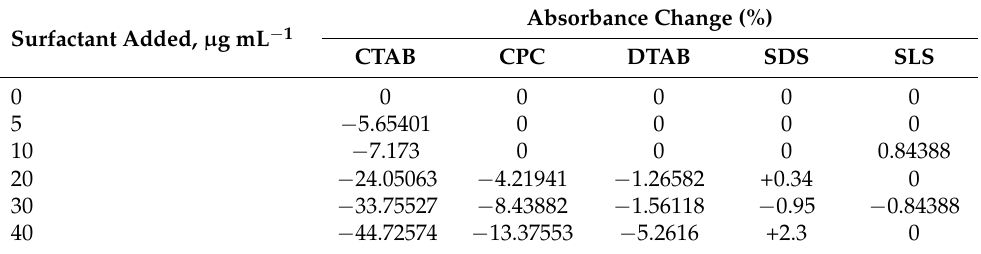
Table 4. Effect of different surfactants on the absorbance change of PCV-Cu chelate.